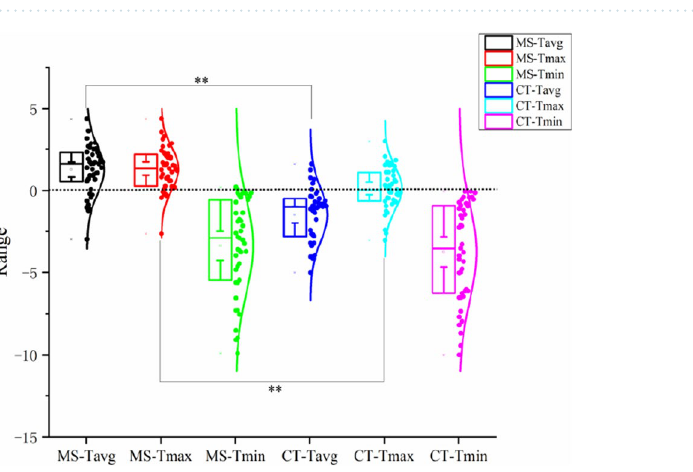
Figure 7. APOS diagram of IRT characteristics of MS group.